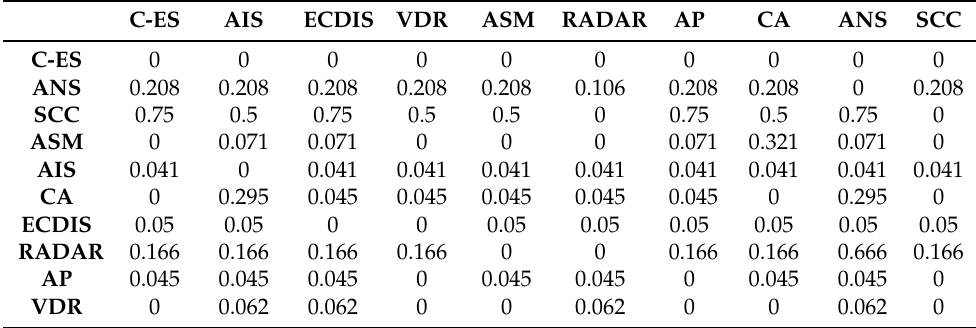
Figure 6. Remotely controlled ship—Navigational CPSs– G (cid:48) Table 6. Effect coefficients—Remotely controlled